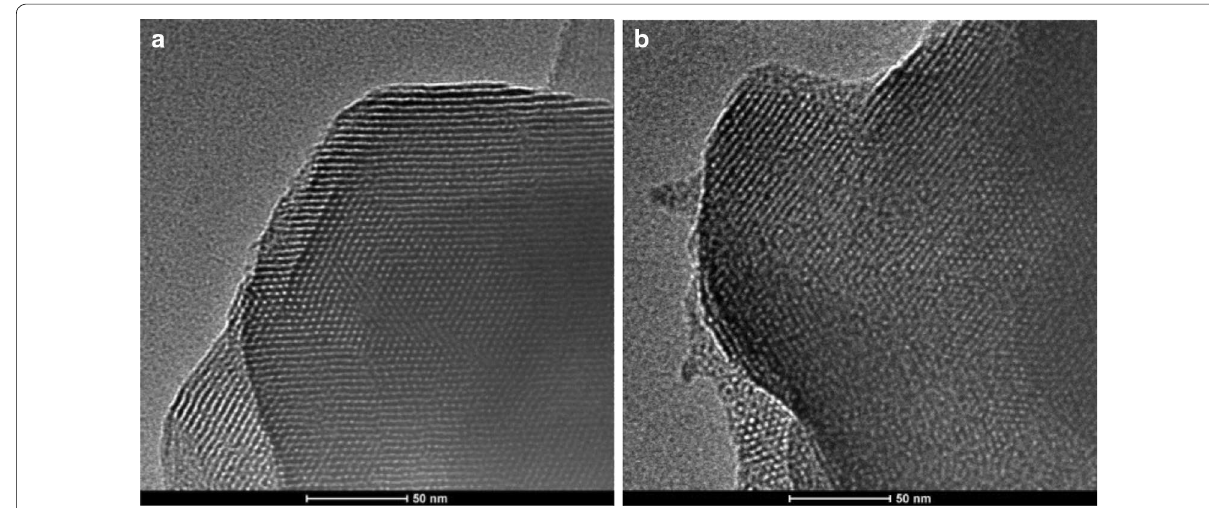
Fig. 5 TEM images of MCM-41 ( a ), TEM images of 20%Ti-5%V-MCM-41 ( b )